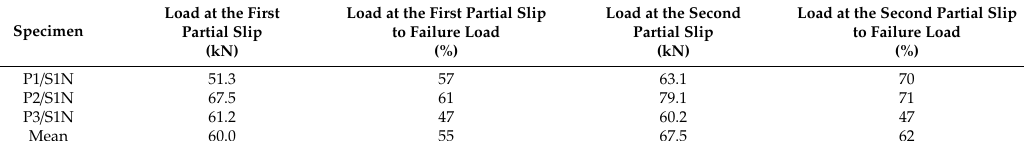
Table 3. Summary of the loads resulting in the partial slip of the specimens tested in S1N series.